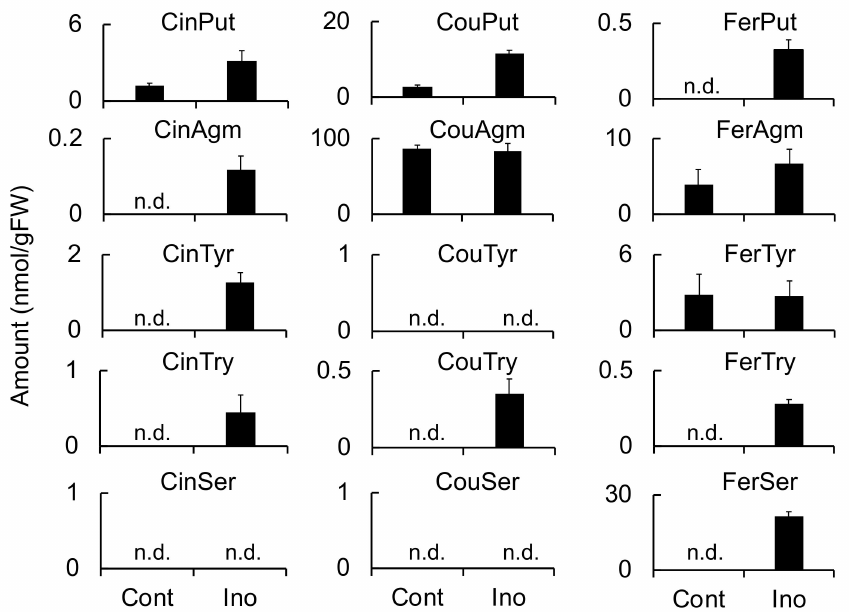
Figure 4. E ff ect of Fusarium culmorum infection on the accumulation of phenylamides in barley roots. Phenylamide levels were measured at 72 h after inoculation using multiple reaction monitoring (MRM) with LC-MS / MS. Values and error bars represent mean ± SD ( n = 3). Cont, control (not inoculated); Ino, inoculated with F. culmorum ; n.d., not detected.